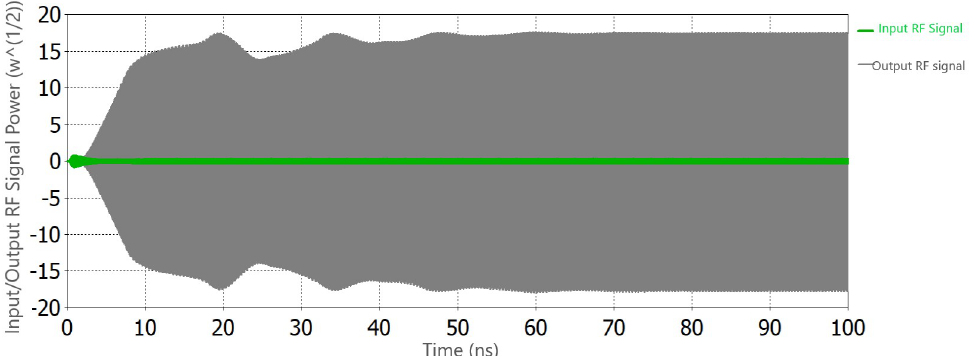
Figure 5. RF input signal and amplified output signal at the input and output cavity ports, respectively.